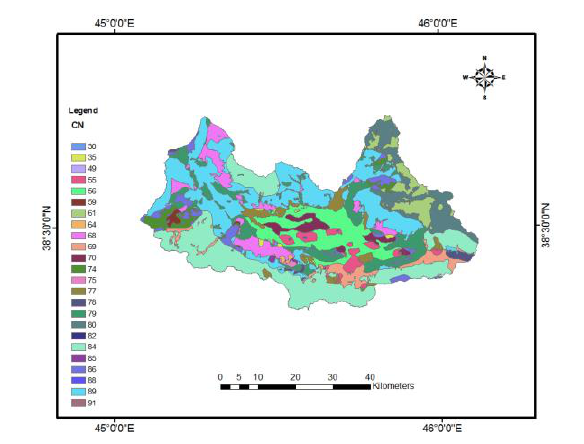
Figure 5. The curve number map of Zilberchai Basin Standard DeviationAverageMinimumMaximumCount 11.27977.51319132377 3 Table 5. Statistical Characteristics of Curve Number Finally the potential maximum retention (S) is determined based on curve number map (5) and equation 4 in ArcGIS (figure 6). The potential maximum retention in the Zilberchai basin is low except some parts.